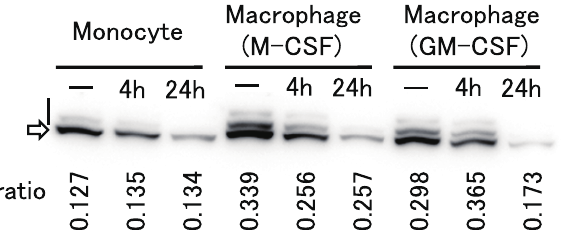
Figure 8. Phosphorylation state of SAMHD1. Monocytes (Mono- cyte), M-CSF-differentiated macrophages (Macrophage (M-CSF)), and GM-CSF-differentiated macrophages (Macrophage (GM-CSF)) were treated with GH123-Nhe/VSV-G for 2 h and incubated at 37 u C for 4 h (4 h) or 24 h (24 h), or mock-treated ( 2 ). Cells were lyzed and subjected for SDS-PAGE containing Phos-tag to separate phosphorylated proteins from nonphosphorylated ones. SAMHD1 proteins were detected by anti-SAMHD1 antibody. Upper bands shown by a vertical bar and a lower band shown by an arrow represent phosphorylated and nonphosphorylated SAMHD1, respectively. Ratios of phosphorylated SAMHD1 levels to total SAMHD1 levels (ratio) are shown in vertical